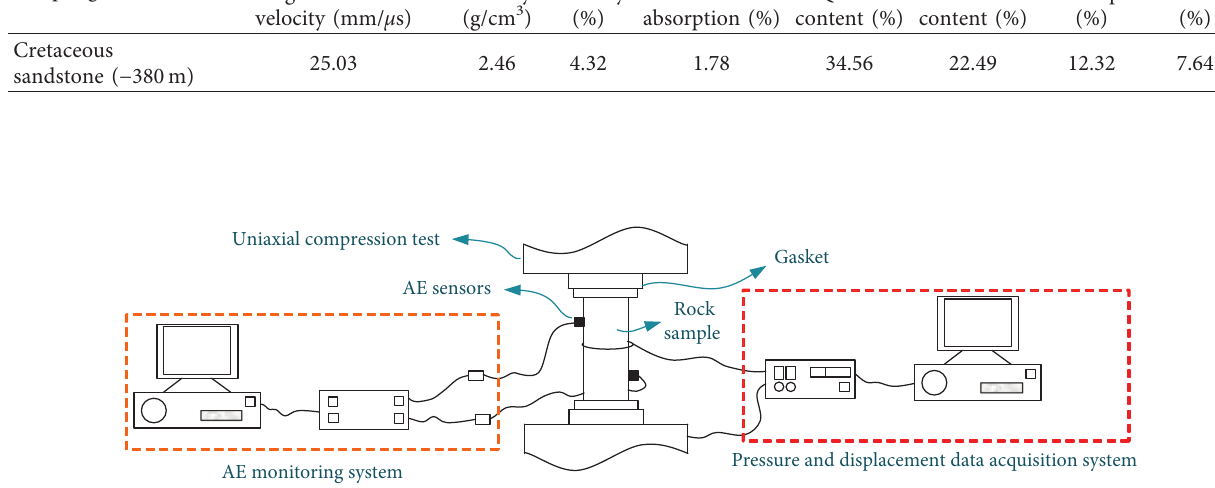
Table 1: Physical parameters and composition analyses of Cretaceous sandstone ( − 380m) specimens in this study. Sampling site